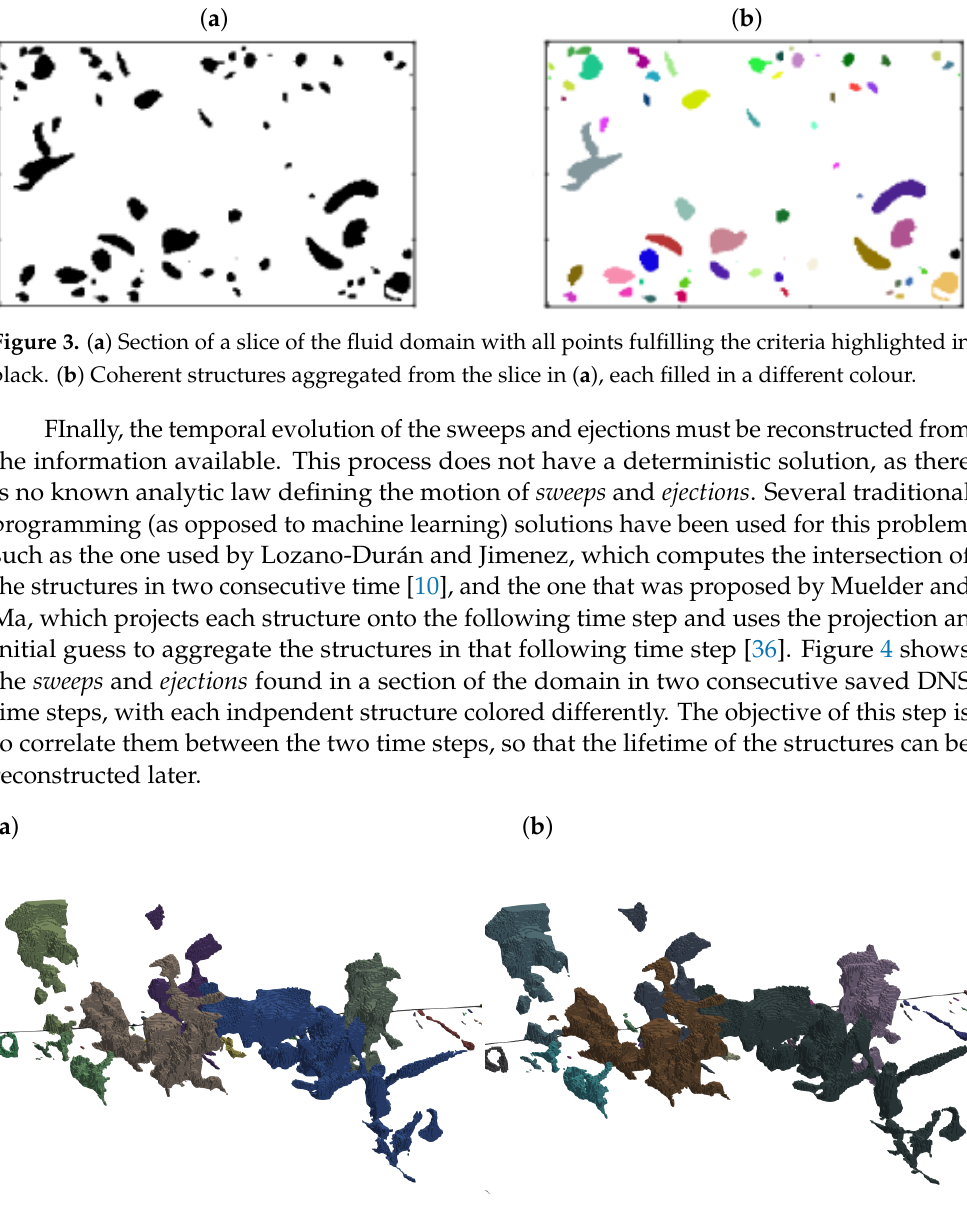
Figure 4. ( a ) Representation of some sweeps and ejections in a single time step of the DNS simulations. The ( b ) Sweeps and ejections in the same region following time